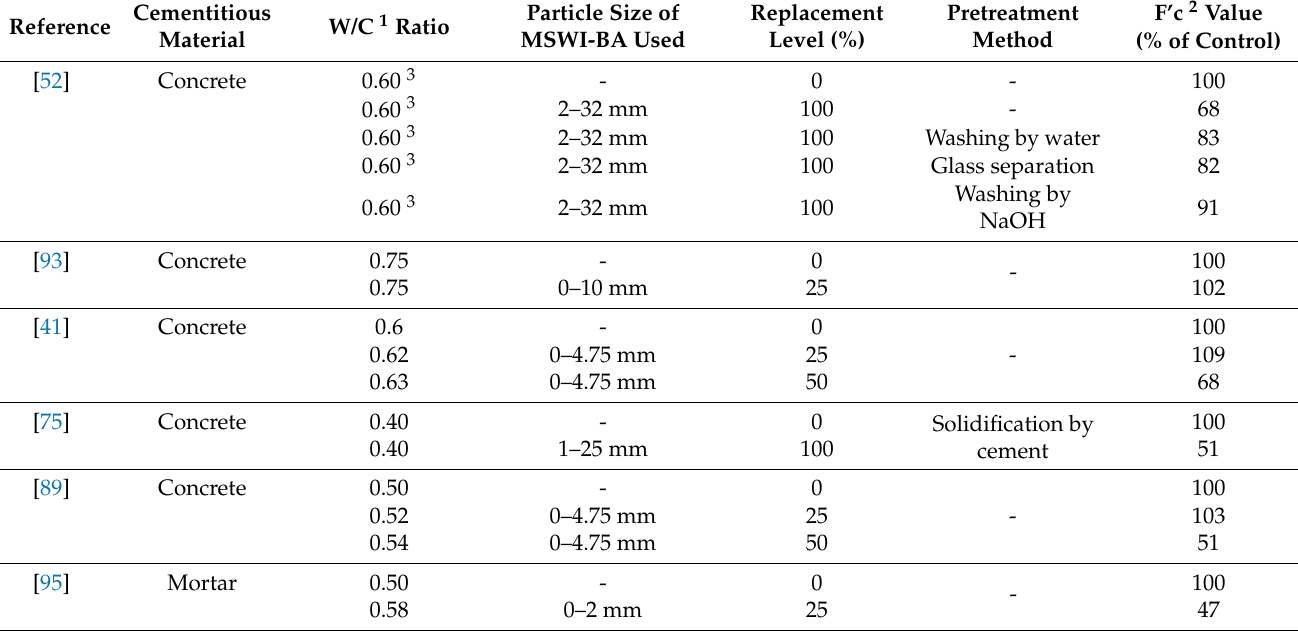
Table 5. Compressive strength at 28 days of cementitious materials containing